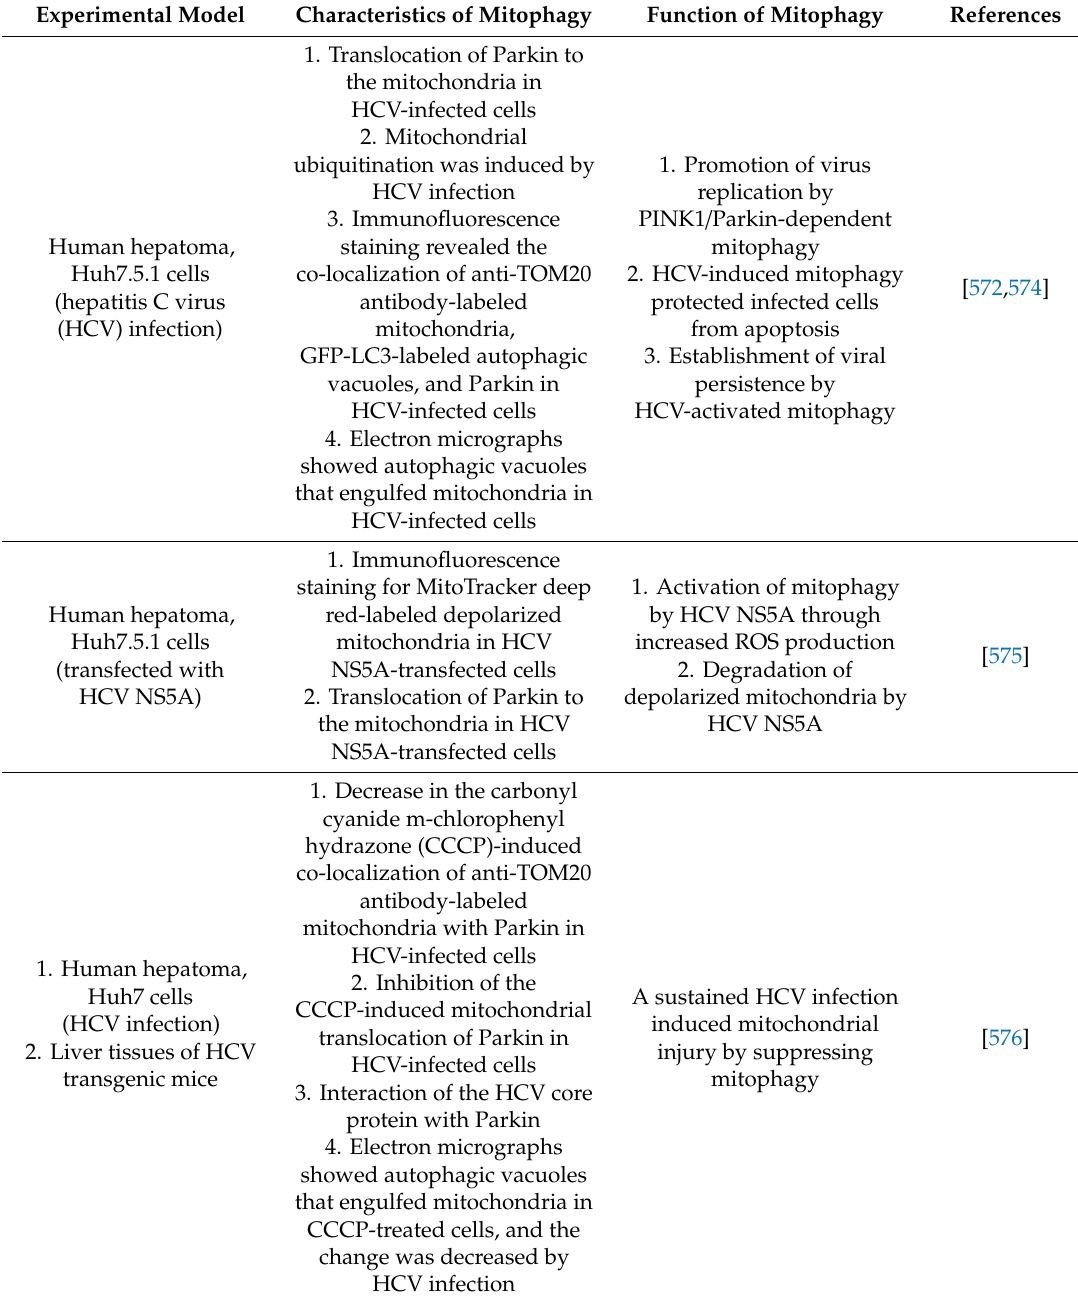
Table 5. Summary of the roles of mitophagy in viral